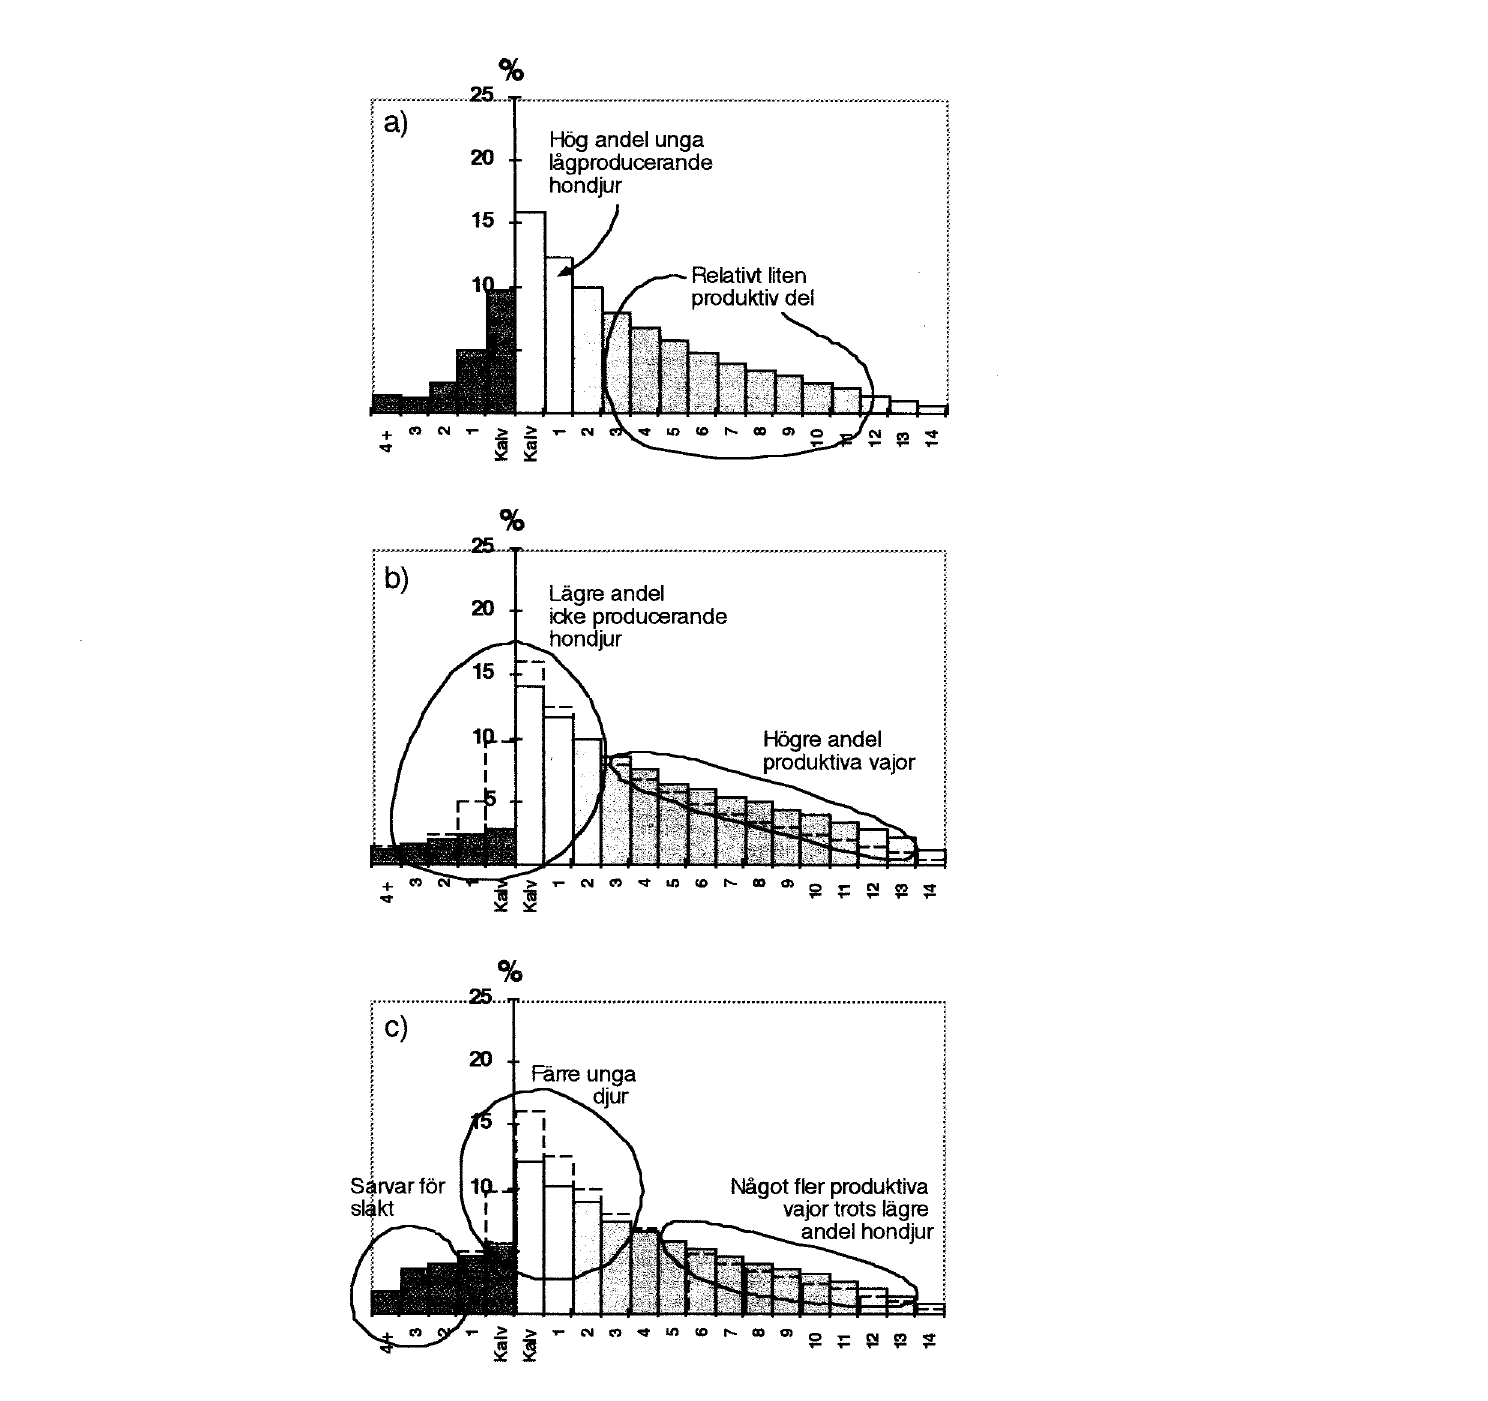
Figur 5. Åldersfbrdelning i renhjorden efter uppnådd jåmvikt i tre slaktaltenativ med något olika konsfbrdelning i livrenhjorden: a) konsfbrdelning 80/20 och proportionellt lika slaktuttag i alla åldersklasser inom resp. kon; b) konsfbrdelning 90/10 och kalvslakt; c) konsfbrdelning 80/20 och kombination av sarv- och kalvslakt. De streckade staplarna i b) och c) visar åldersfbrdelning i a).